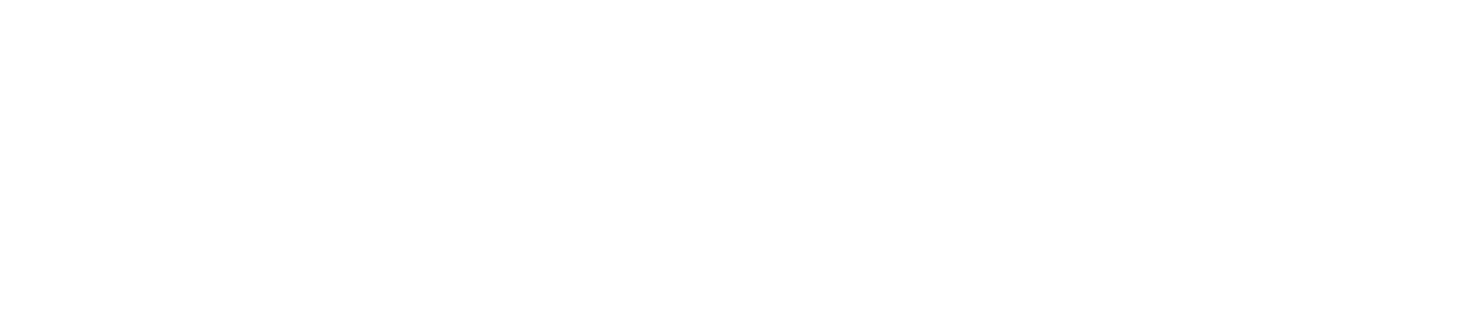
Figure 4 The effect of a ± 10% change in the tax rate on the internal rate of return of formulae A and B amounting to 10% and 5% from years 6 to 10,